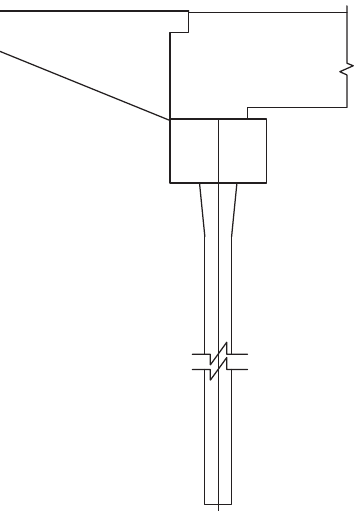
Figure 4: Integral abutment of Shangban